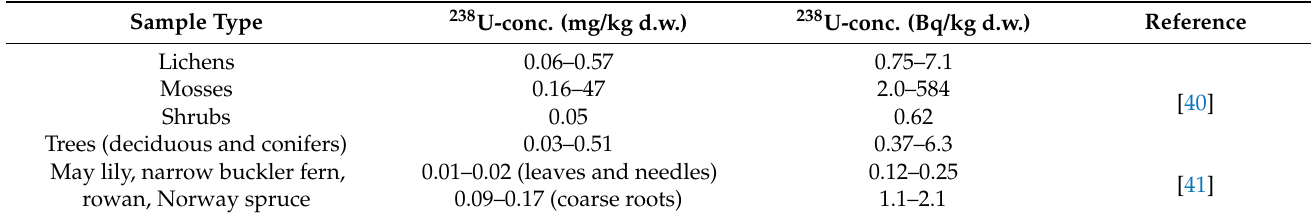
Table 4. Uranium concentration in Finnish environmental